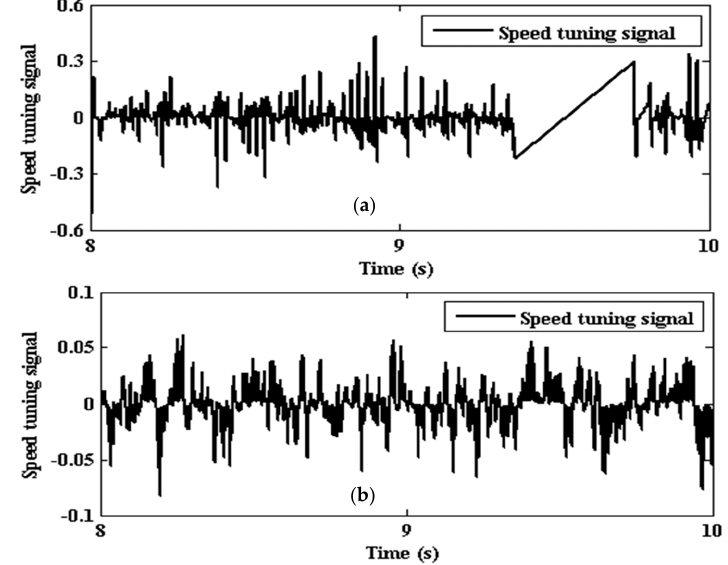
Figure 22. Speed tuning signal for 150% incorrect setting of stator resistance (R s ) and rotor time constant (T r ) for ( a ) SMLO 1; and ( b ) SMLO 2.